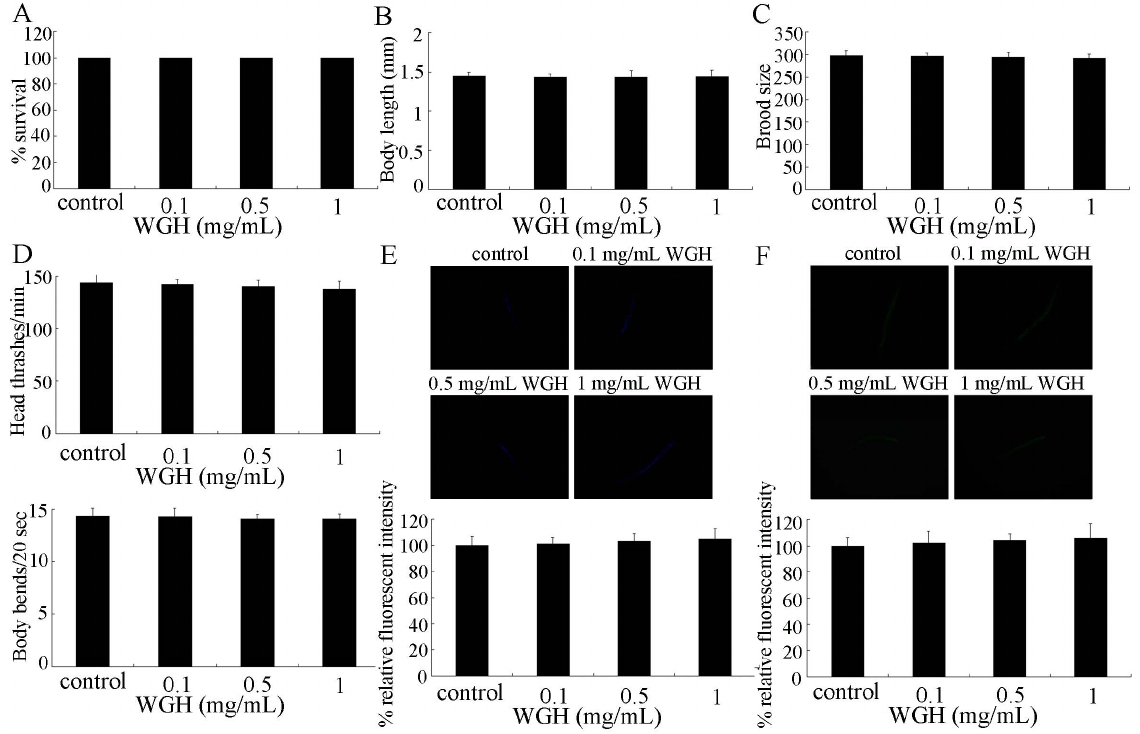
Figure 1. Toxicity assessment of WGH on C.elegans . (A) Effects of WGH on lethality. (B) Effects of WGH on growth. (C) Effects of WGH on reproduction. (D) Effects of WGH on locomotion behavior as indicated by head thrash and body bend. (E) Effects of WGH on intestinal autofluorescence. (F) Effects of WGH on intestinal ROS production. WGH treatment was performed for 24-hr from L4-larvae. WGH, wheat gluten hydrolysate. Bars represent means 6